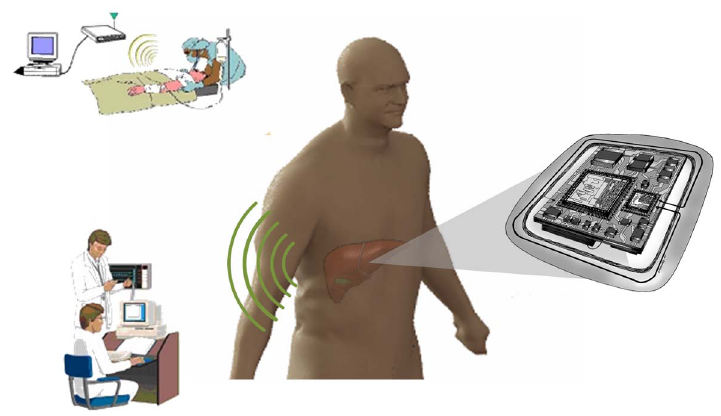
Figure 1. Schematic of the envisioned wireless sensor implanted on the liver.